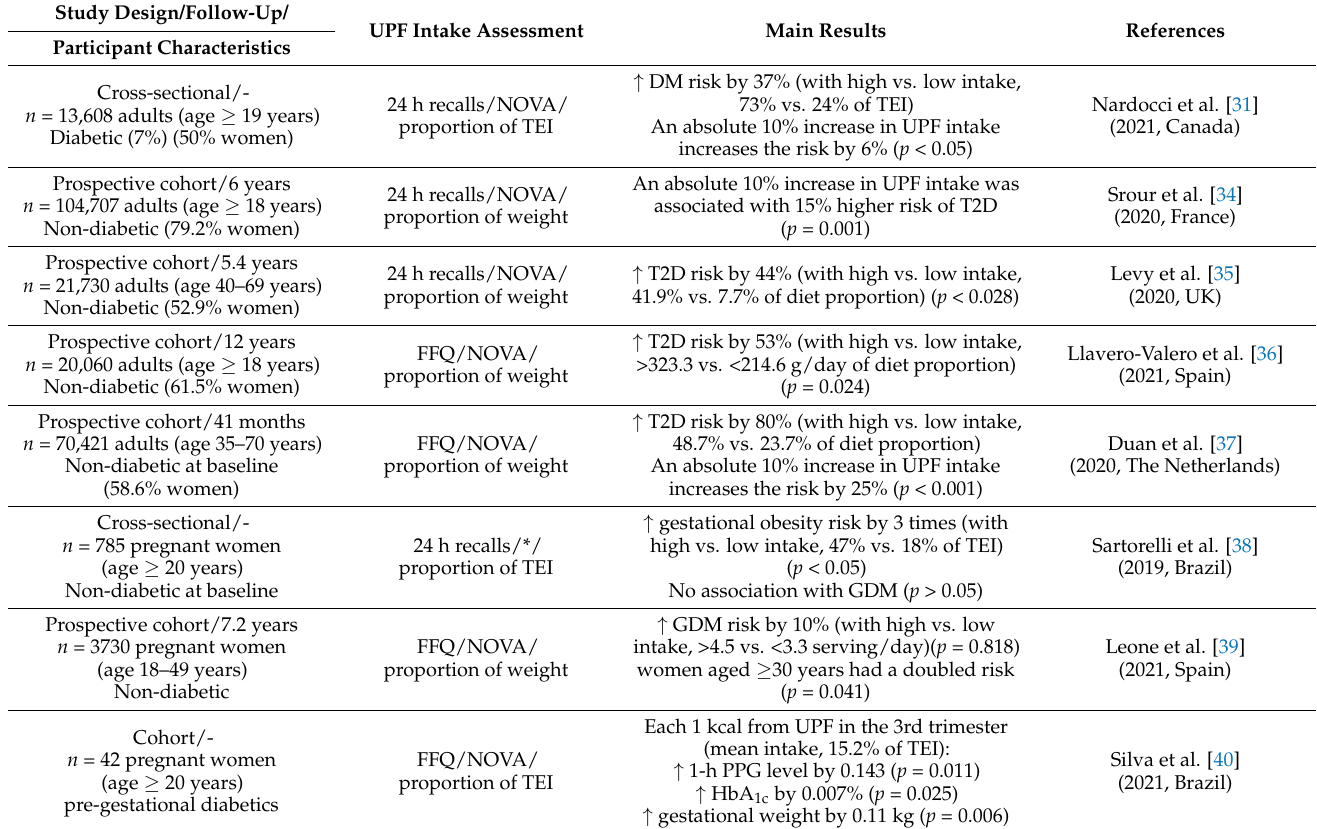
Table 1. Summary of studies investigating the association between ultra-processed food consumption and risk of diabetes and gestational